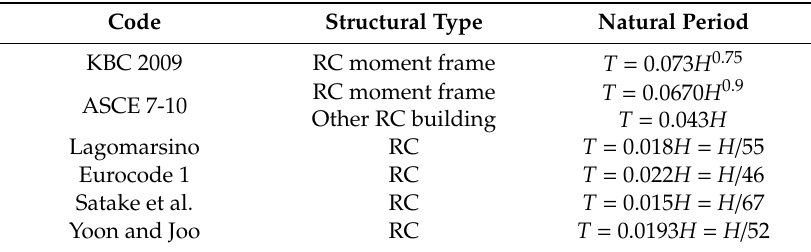
Table 1. Empirical formulae for estimating natural